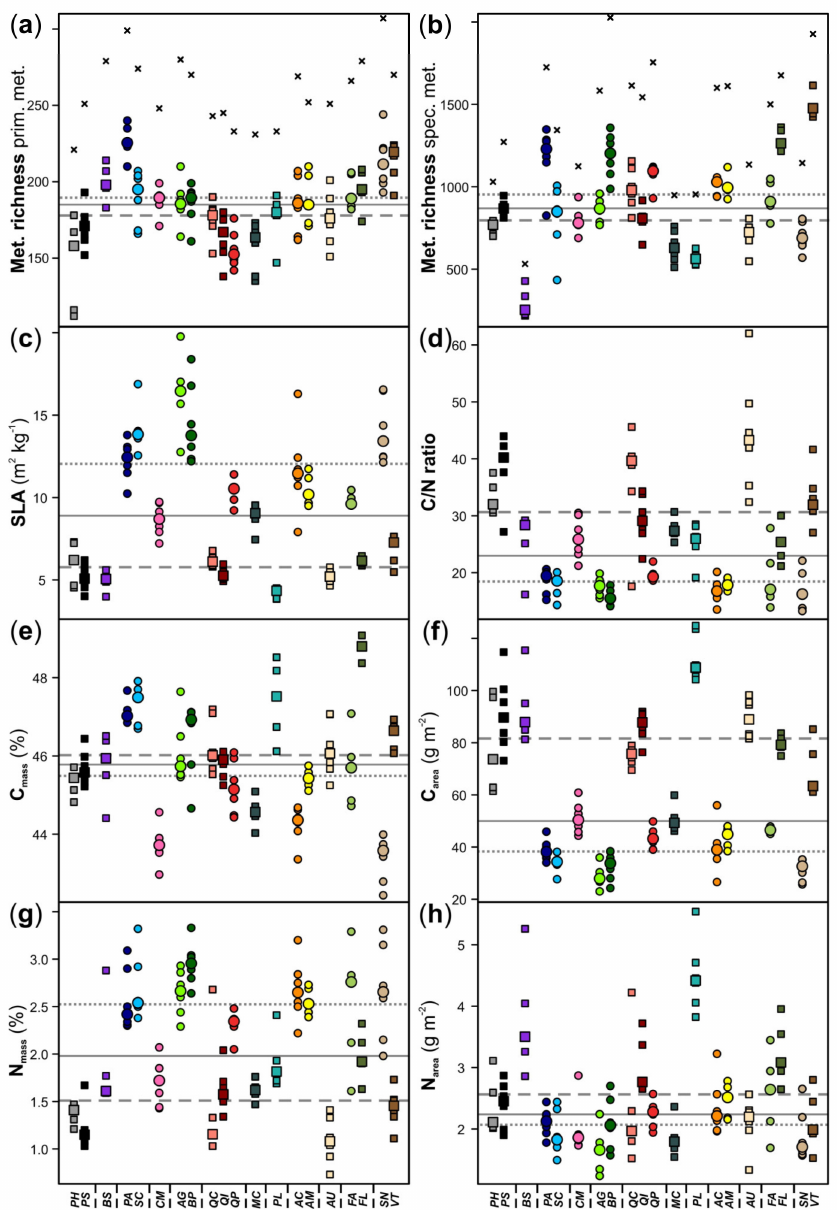
Figure 6. Stripcharts of leaf traits of 20 plant species (deciduous: circles; evergreen: squares): ( a , b ) metabolite richness of features of the primary and specialized metabolism; ( c ) specific leaf area (SLA); ( d ) carbon (C) to nitrogen (N) ratio; ( e ) C content (C mass ); ( f ) C per leaf area (C area ); ( g ) N content (N mass ); ( h ) N per area (N area ). Medians are shown as larger symbols (species) and horizontal gray lines (overall: solid; deciduous: dotted; evergreen: dashed), respectively. The vertical dashed lines at the x axes separate the species by plant families. For species abbreviations and taxon assignments, see Table